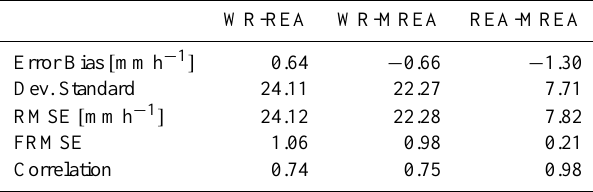
Table 1. Error analysis of the difference between the rain fields of WR and those at obtained with REA in Eq. (3) and MREA in Eq. (4). Difference between REA and MREA are given in terms of statistical